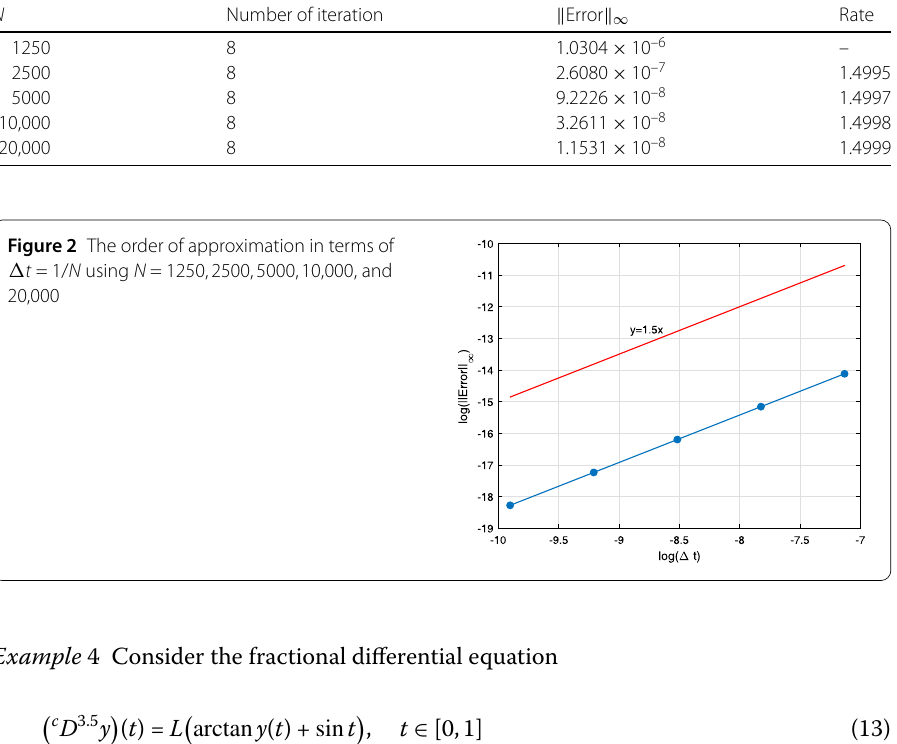
Table 2 Number of iteration and rate of convergence for Example 3 N